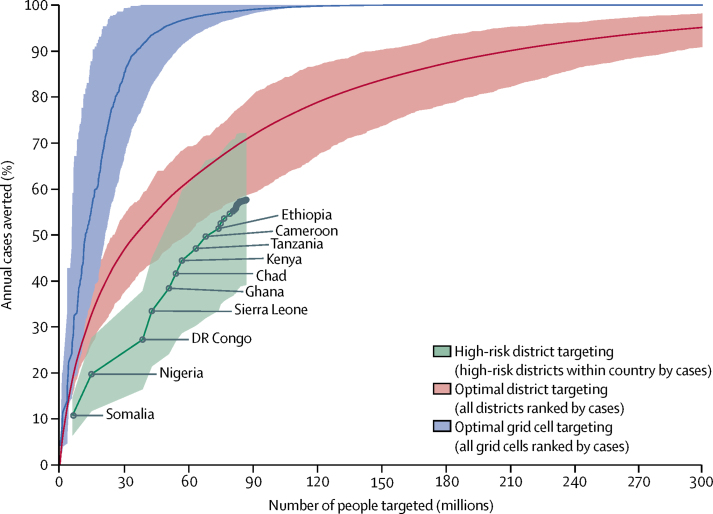
Annual cholera cases in sub-Saharan Africa averted as a function of the number of people targeted with an ideal intervention or mix of interventionsThe optimum grid cell targeting curve (blue) represents a strategy targeting all 20 km × 20 km grid cells in rank order by number of cases. The optimum district targeting curve (red) represents a strategy targeting all districts in rank order by number of cases regardless of country. The green curve represents a more realistic and practical strategy that targets all high-risk districts in each country at once, with countries ranked by the number of cases prevented. Lines are the mean values and shading shows the 95% credible intervals. Strategies targeting grid cells or districts by ranked incidence instead of number of cases are presented in the appendix.